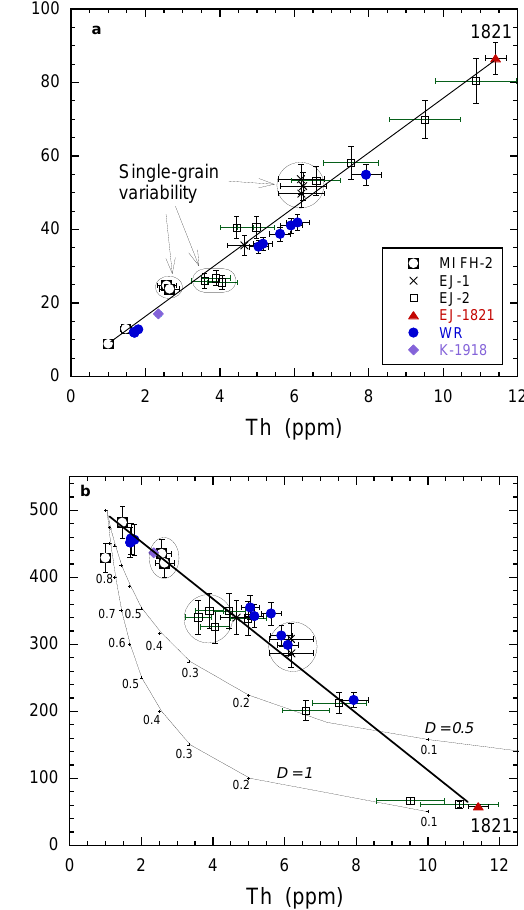
Fig. 4. Linear correlations of Rb, Sr, and Th concentrations be- tween extreme magma compositions produced during the 2010 Eyjafjallajökull eruption. Four spot analyses of three olivine-hosted melt inclusions are shown for comparison. Larger error bars for the Figure 3 in-situ analysis, compared to those of whole-rock (WR), are caused Sigmarsson et al. by small ablation crater-size (diameter of 11µm) due to small area of crystal-free glass patches and consequent lower count rates of each element. Multiple analyses of single grains are encircled in both panels. In (b) , two curves of melt evolution during hypotheti- cal crystal fractionation are shown for different D Sr (assuming D Th close to 0) with the remaining melt fractions indicated. The origin of the 1821–1823 alkaline rhyolite will be addressed elsewhere but it is consistent with over 90% fractional crystallisation from prim- itive basalt. This differentiation mechanism appears dominant at Icelandic volcanoes close to the periphery of the island (Martin and Sigmarsson, 2007). Apatite fractionation, where D Sr can be as high as 5 (Prowatke and Klemme, 2006), together with that of plagio- clase, having D Sr in the range 1–3 (Fabbrizio et al., 2009), account for a bulk D Sr as high as unity. See Fig. 3 for